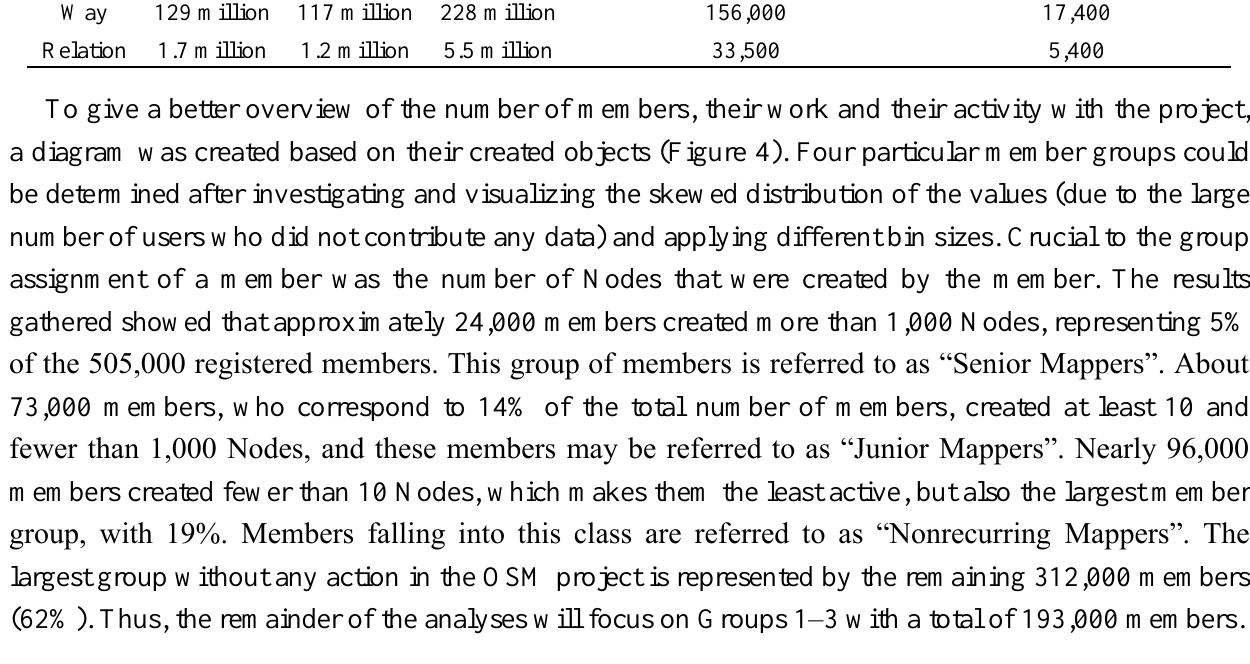
Figure 4. Distribution of registered members based on their node